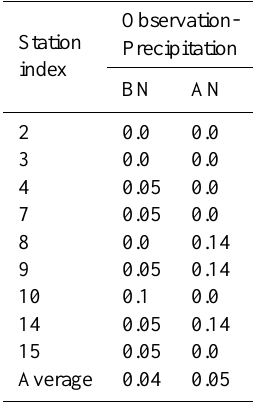
Table 7. The false alarm rate of nutrient forecasts developed using precipitation forecasts and December